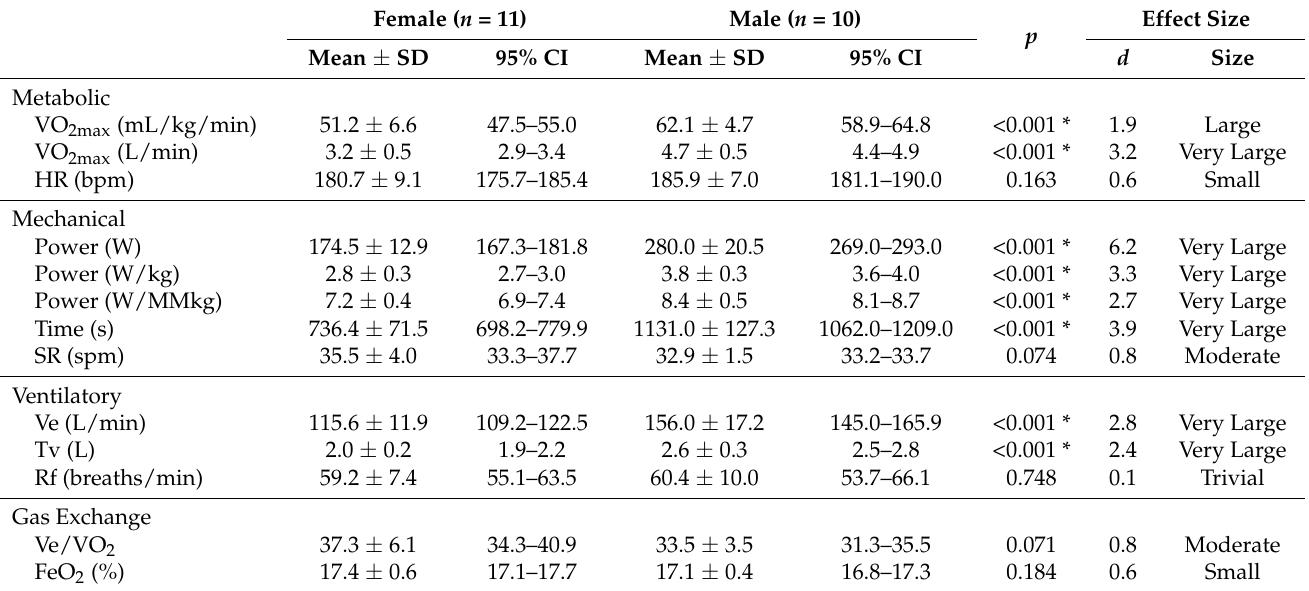
Table 2. Mean values of maximal aerobic power and difference between female and male